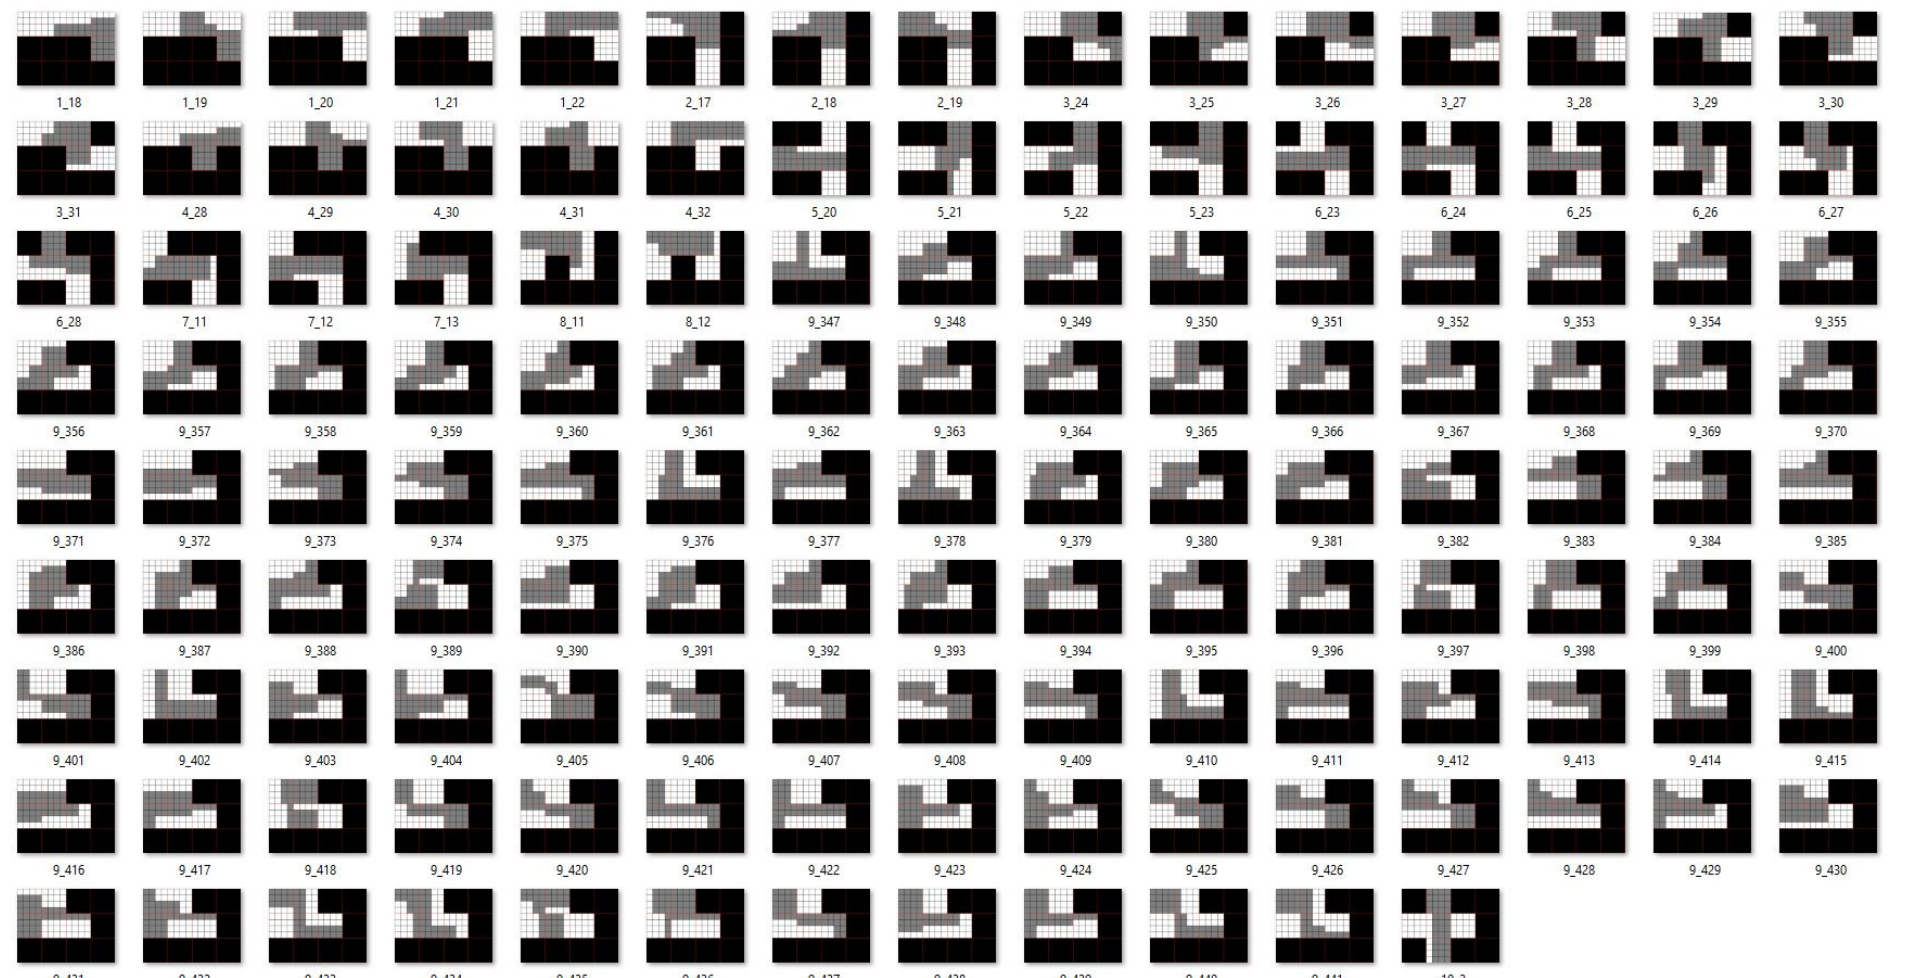
Figure 19. Ave Group: A/S = 1.13 with 132 models.